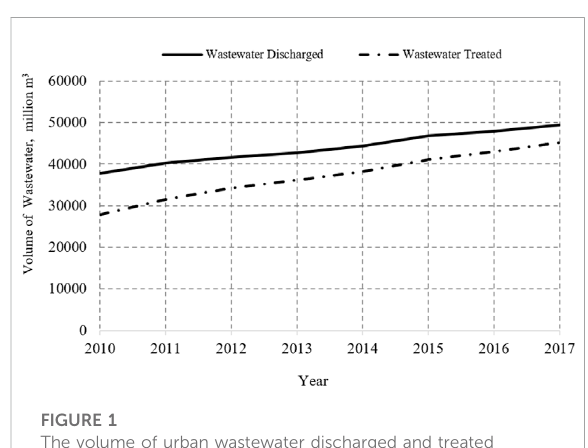
FIGURE 1 The volume of urban wastewater discharged and treated from 2010 to 2017 in